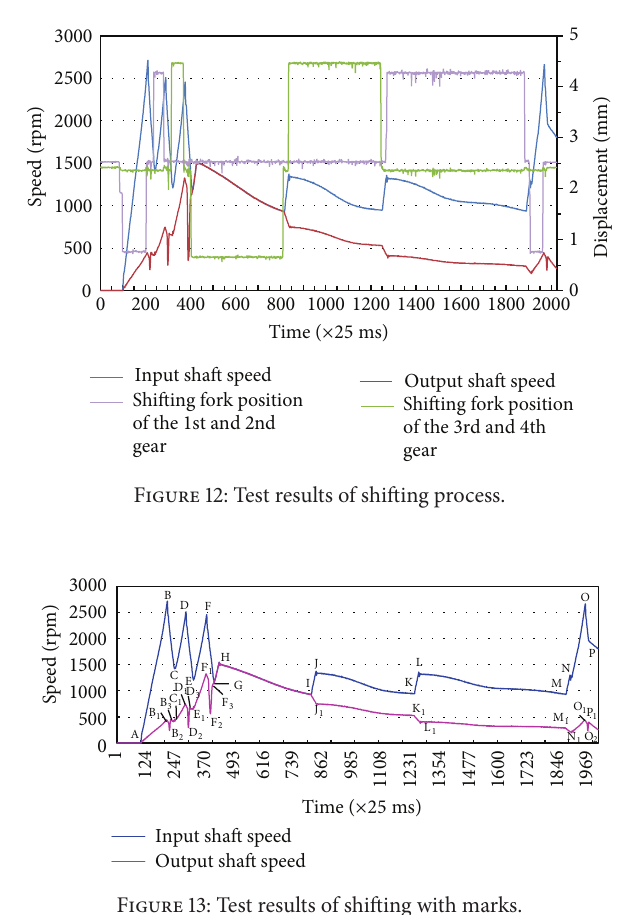
Figure 13: Test results of shifting with marks.